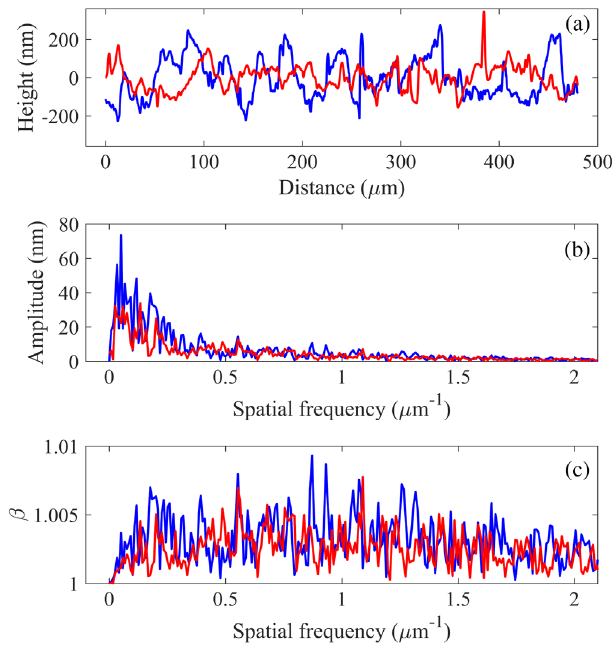
FIG. 2. Surface roughness analysis of the polished top piece before (blue lines) and after (red lines) the high power test. The two measurements were conducted at two close sites within 1 mm distance. (a) Surface profile. Before the high power test, the peak- to-peak and root-mean-square roughness is 503 and 108 nm, respectively. After the high power test, the peak-to-peak and root- mean-square roughness is 503 and 66 nm, respectively. (b) Spatial frequency spectrum. (c) Field enhancement